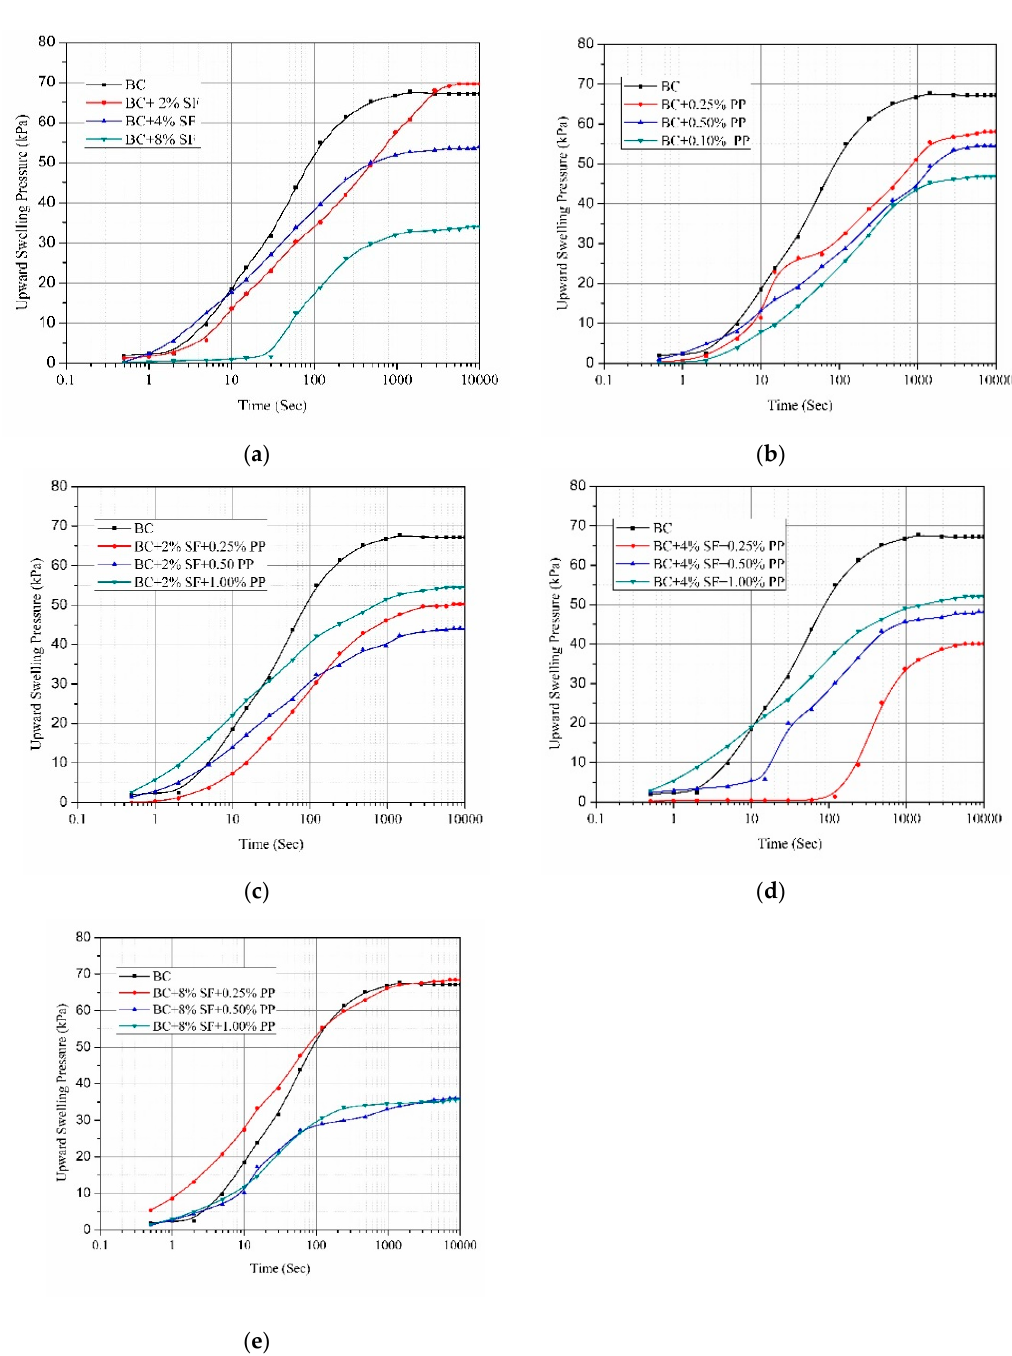
Figure 2. (a) Upward swelling pressure curve for silica fume-reinforced expansive soil. ( b ) Upward swelling pressure curve for polypropylene fiber-reinforced expansive soil. ( c ) Upward swelling pressure curve for polypropylene fiber reinforced with 2% silica fume expansive soil. ( d ) Upward swelling pressure curve for polypropylene fiber reinforced with 4% silica fume expansive soil. ( e ) Upward swelling pressure curve for polypropylene fiber reinforced with 8% silica fume expansive soil. It can be ascertained that expansive soil absorbs water and upon saturation, changes in the swelling ratio without pressure can be roughly divided into three stages: (1) Rapid expansion period.